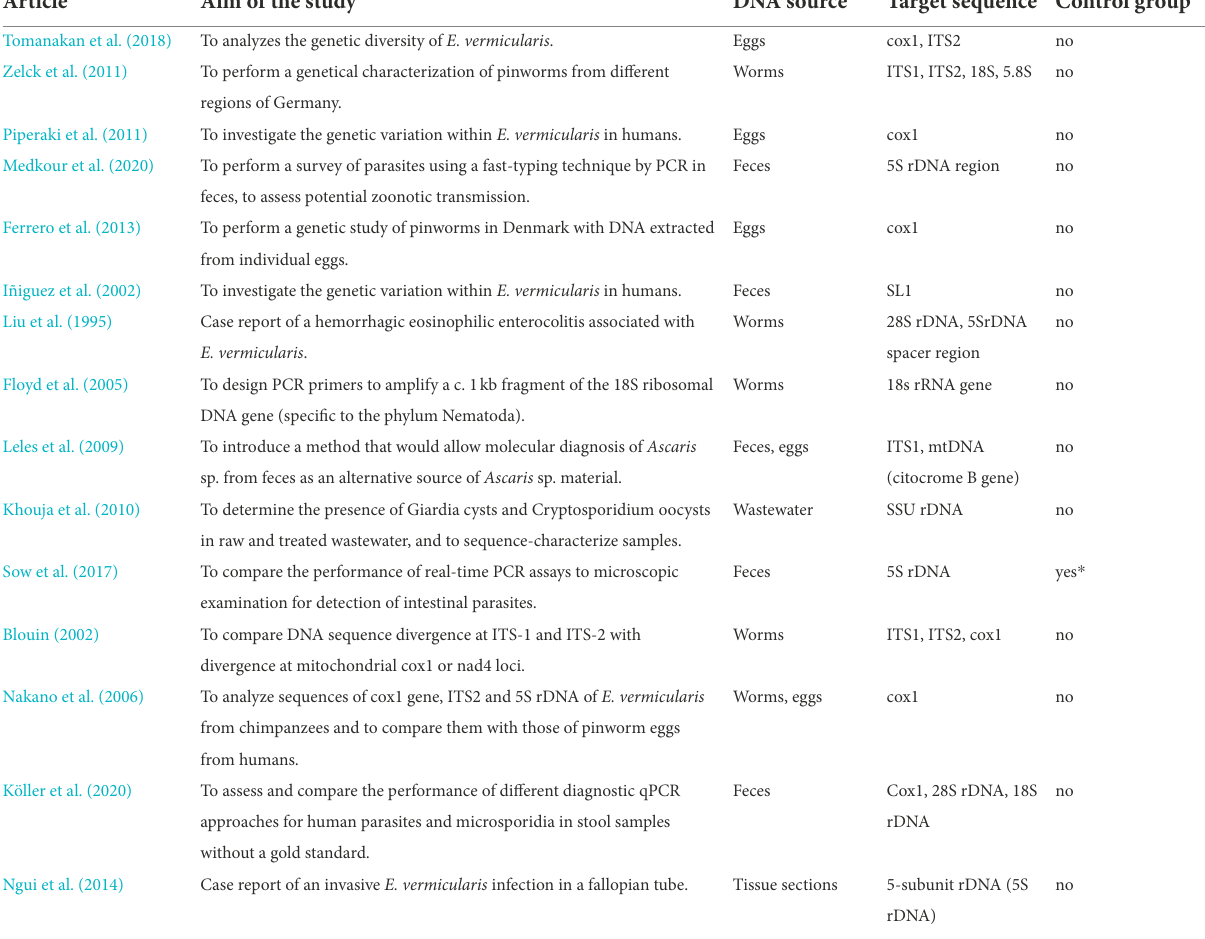
TABLE 1 Studies that used the PCR analysis for the characterization of E. vermicularis . Aim of the